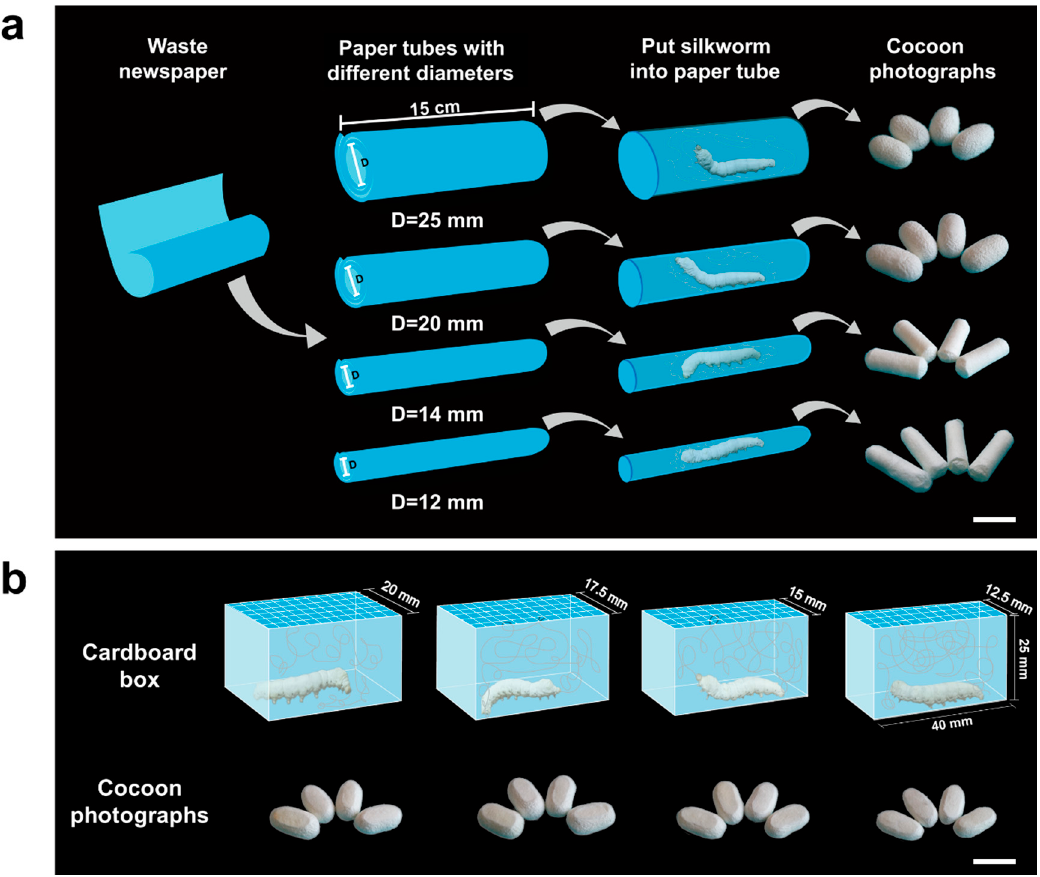
Figure 1. Schematic illustrations for the fabrication processes, and photographs of each type of modified silkworm cocoon: ( a ) paper tube (PT) cocoons and ( b ) cardboard box (CB) cocoons. Scale bar for silkworm cocoons is 2 cm.